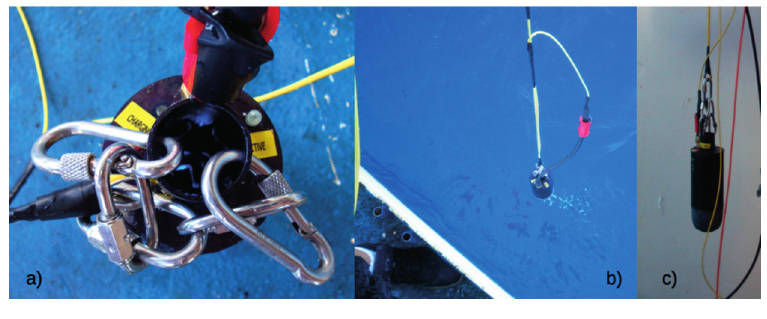
Figure 10. The T-FLaPpro : ( a ) blue LEDs inside the measure cell; ( b) the probe during the launching; ( c ) a wide-angle view of the probe.